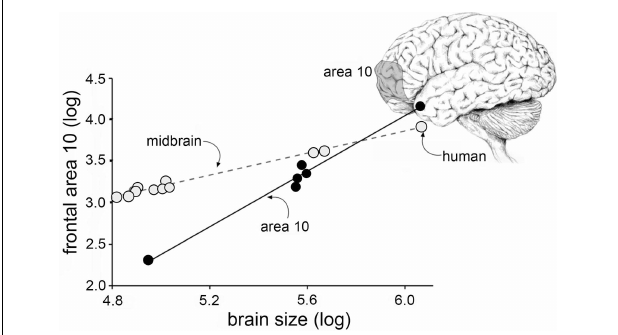
FIGURE 1 | Cortical areas expand disproportionately with increases in brain size. Plot shows the relative size of the midbrain (monkeys, apes, human) and frontal cortical area 10 (apes and human, only) plotted as a function of overall brain size. As shown, the slope for midbrain is relatively flat: with a slope of < 1 the midbrain occupies a progressively smaller proportion of brain volume as brain sizes increase. In contrast, with a slope of > 1, Area 10 grows disproportionately to overall volume with increases in brain volume (Area 10 results from Semendeferi et al.,